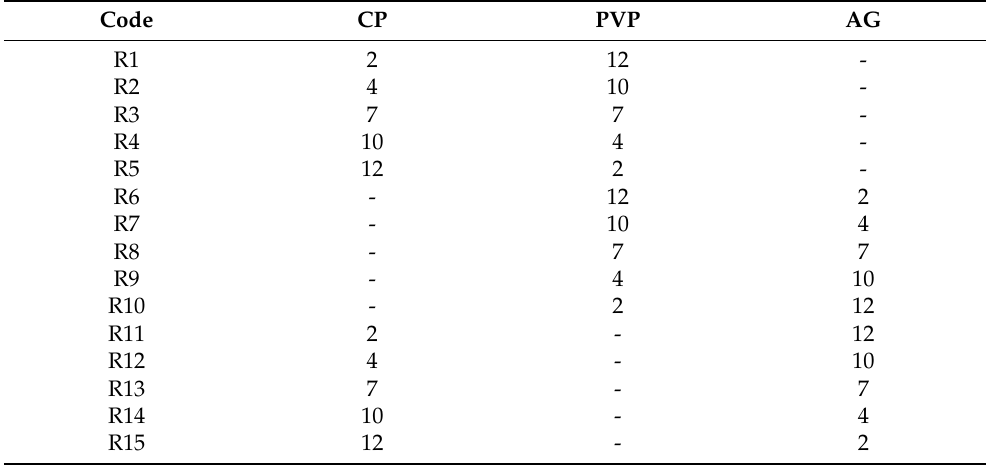
Table 8. Percentage composition (%, w / w ) of polymers to formulate the mucoadhesive buccal tablet. Code CP